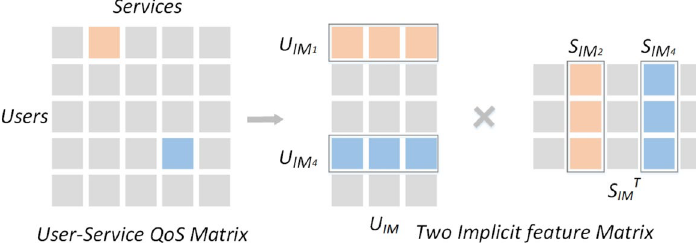
Fig. 4 The implicit feature generated through